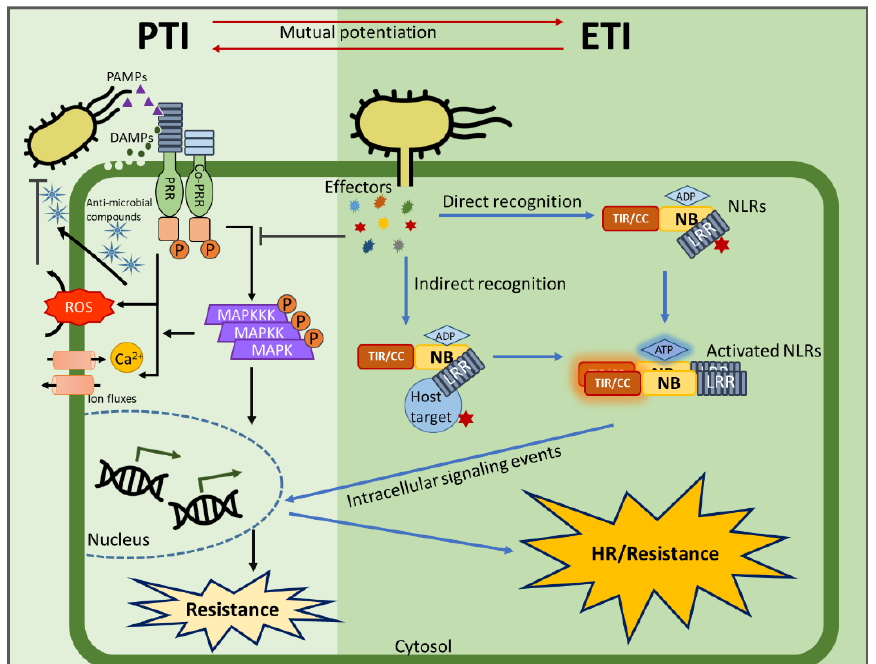
Figure 1. Schematic view of pattern-triggered immunity (PTI) and effector-triggered immunity (ETI) in plants. The first layer of induced immunity, called PTI (indicated by black arrows), is activated by the recognition of pathogen-associated molecular patterns (PAMPs) or damage-associated molecular patterns (DAMPs) through pattern recognition receptors (PRRs). Several PTI signaling events occur, such as activation of the mitogen-activated protein kinases (MAPK) kinase cascades, an influx of Ca 2+ into the cytosol, and production of reactive oxygen species (ROS). Antimicrobial compounds are produced and the defense genes are activated. However, to suppress PTI, the pathogens deploy effectors. When they are recognized by nucleotide-binding (NB) and leucine-rich-repeat (LRR)-containing receptors (NLRs), the second immune layer, called ETI (indicated by blue arrows), takes place. NLRs directly or indirectly perceive pathogenic effectors, leading to a conformational change, which together with several intracellular signaling events, ultimately trigger the hypersensitive response (HR) or other defense responses. Surprisingly, the most recent studies reported that PTI and ETI are mutually linked and together potentiate the immune response (indicated by red arrows).